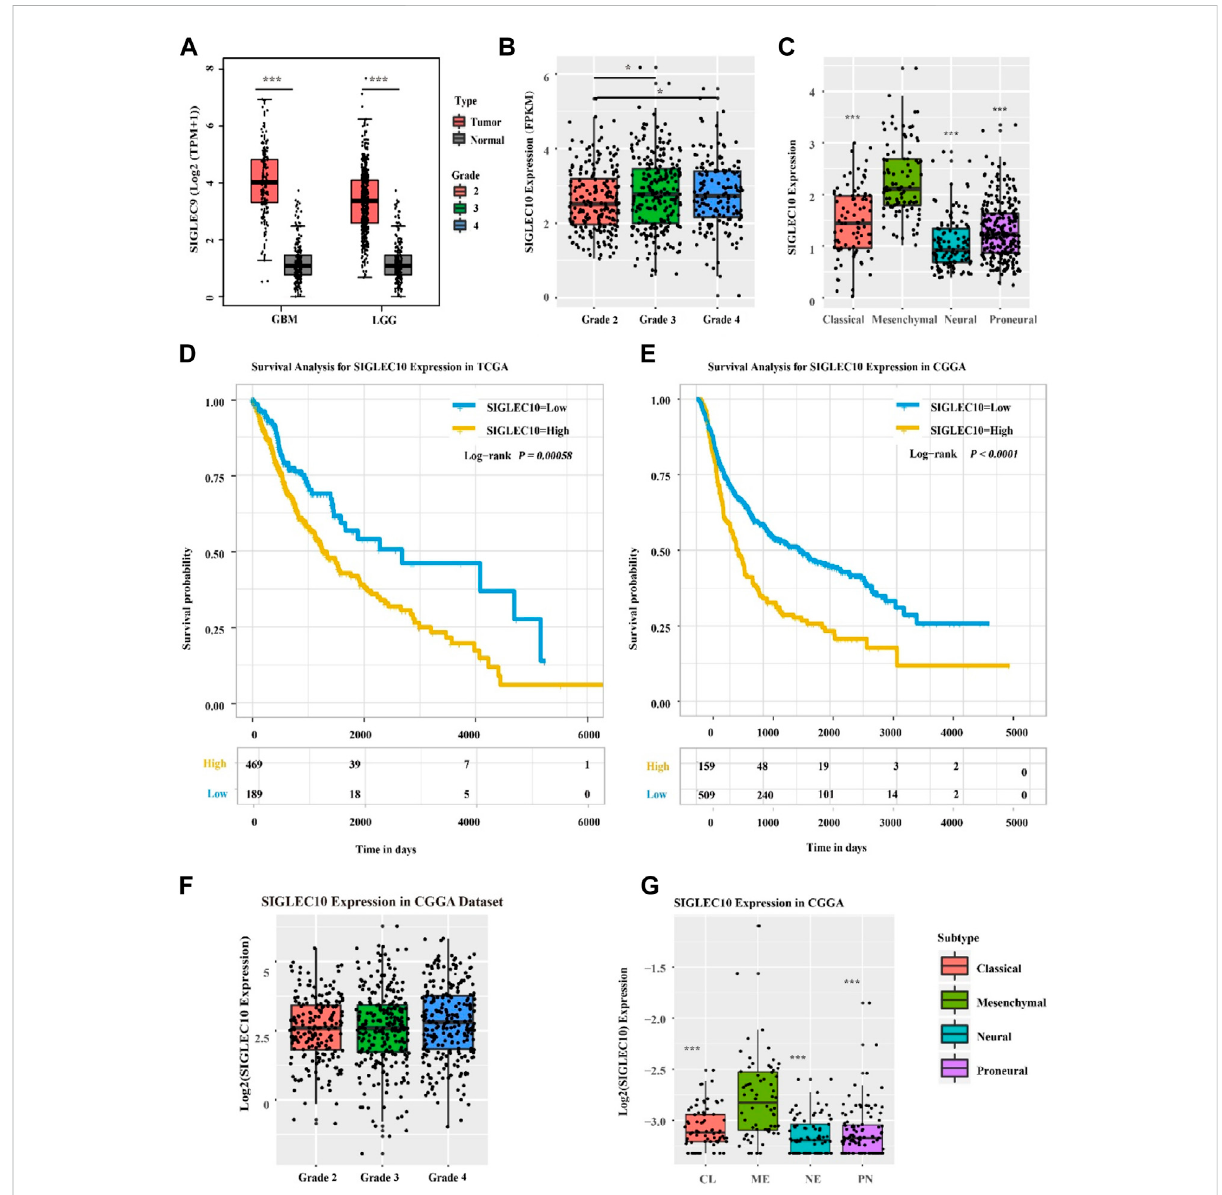
FIGURE 1 Expression of siglec10 in different subtypes and grades of gliomas. (A) In TCGA dataset, siglec10 expression was higher in tumor tissue than normal tissue in LGG and GBM (*represented p ＜ 0.05). (B) In TCGA dataset, siglec10 expression was higher in high-grade gliomas than low-grade gliomas (*represented p ＜ 0.05). (C) In TCGA dataset, siglec10 expression was higher in the mesenchymal subtype than classical, neural, and proneural subtypes (**represented p ＜ 0.01). (D) High siglec10 expression patients had shorter survival prognosis than low siglec10 expression patients in TCGA dataset ( p = 0.00058). (E) High siglec10 expression patients had shorter survival prognosis than low siglec10 expression patients in the CGGA dataset ( p ＜ 0.0001). (F) In the CGGA dataset, siglec10 expression was higher in high-grade gliomas than low-grade gliomas. (G) In